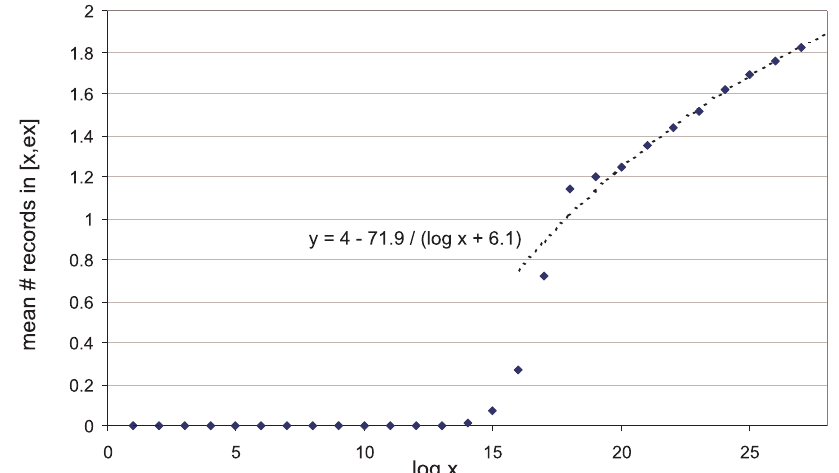
Figure 8. Prime triplets ( p , p + 2, p + 6), p = r + nq ∈ P c , k = 3, q = 16001. Mean number of maximal gaps G c observed for p ∈ [ x , ex ] , x = e j , j ≤ 27. Averaging for all H -allowed r . Dotted curve is a hyperbola with horizontal asymptote y = 4.